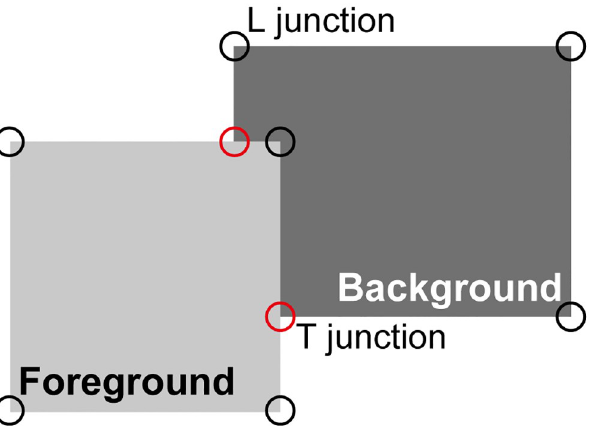
Fig 9. Overlapping squares as an example of cluttered scenes. In this illustration, the light-gray “foreground” square appears in front of the darker “background” rectangle; the perception is not that of a light-gray square adjacent to a darker L-shaped object. Red and black circles mark T and L junctions, respectively, and are not part of the visual display. Such local cues modulate the responses of BOS cells in addition to the grouping cell inputs discussed in the present study